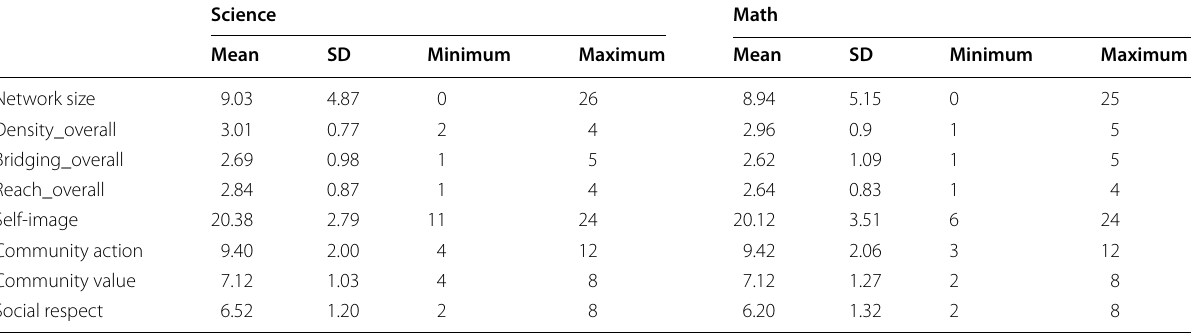
Table 2 Descriptive Statistics of teacher identity factors and CoP network variables by